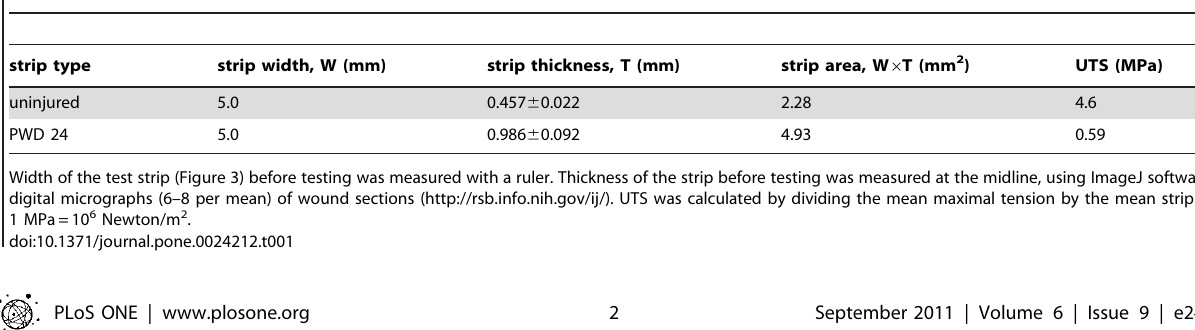
Figure 1. Gross and microscopic anatomy. Murine ventral abdominal wall from unwounded (A, C, E) vs. wounded (B, D, F) 16 week old subjects is shown. (A&B) Transverse whole section of the ventral midline abdominal wall stained with hematoxylin and eosin. Heavy black arrow=site of vertical midline incision (red line in Figure 3A); dotted oval=site of incisional wound. Bars=1 mm. (C&D) Low-power micrograph of abdominal wall corresponding to the above heavy black arrow and dotted oval. Bars=100 m m. (E&F) Higher magnification of ventral midline abdominal wall at the sub-epidermal level. Bars=10 m m. d=dermis; e=epidermis; g=gland; hf=hair follicle; la=linea alba; p=peritoneum; pc=panniculus carnosus muscle; ra=rectus abdominus muscle; sc=subcutaneous tissue. doi:10.1371/journal.pone.0024212.g001 Table 1. Ultimate tensile strength (UTS) of the mouse abdominal wall on PWD 24 compared with UTS of abdominal wall from uninjured, age-matched, controls at 16 weeks of